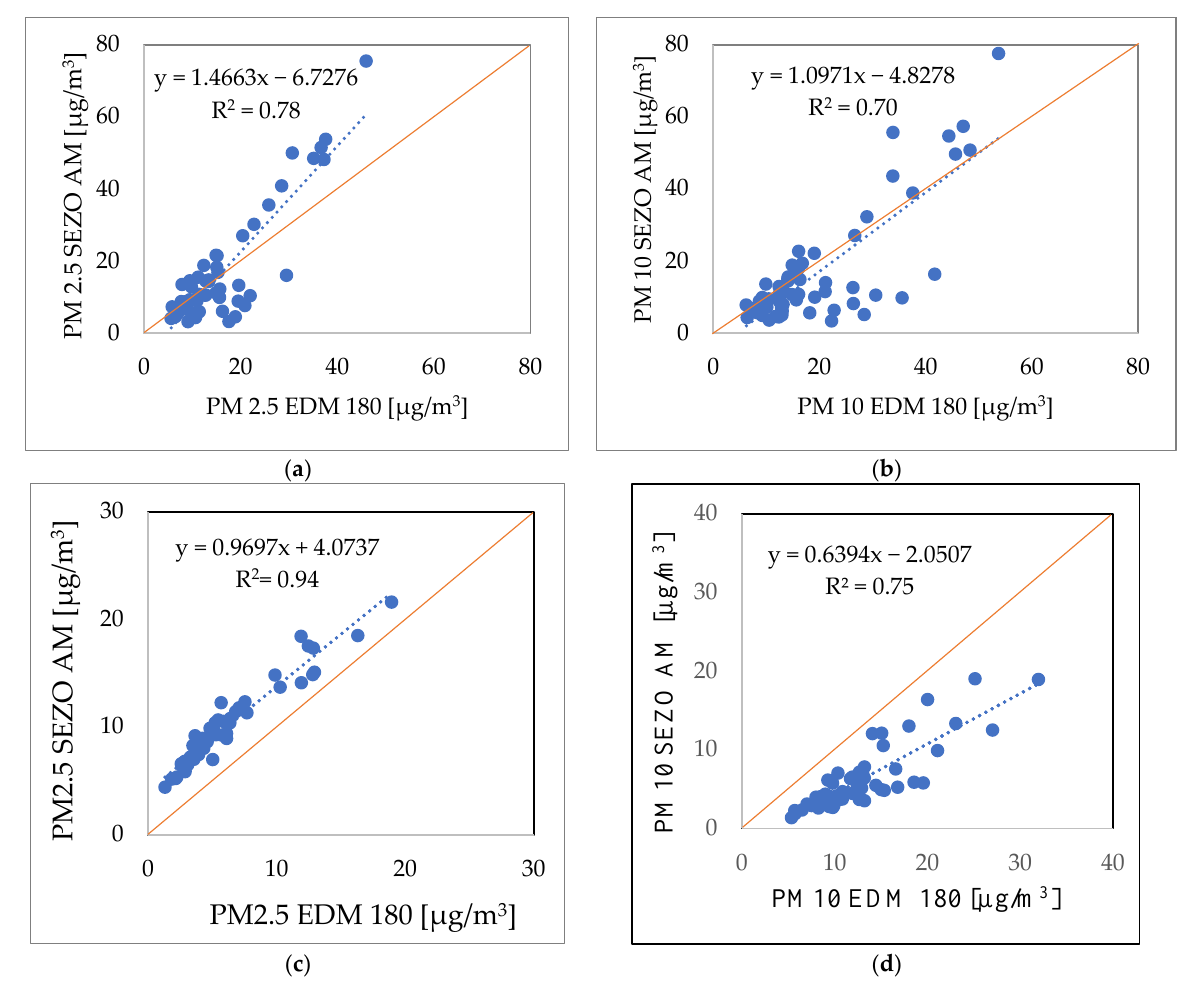
Figure 8. Relationship between the concentration values measured with the SEZO AM and EDM 180 analysers for ( a ) PM2.5 and ( b ) PM10 in March–April and for ( c ) PM2.5 and ( d ) PM10 in August–September . Positive (Direct) Relationship is marked with the red line.